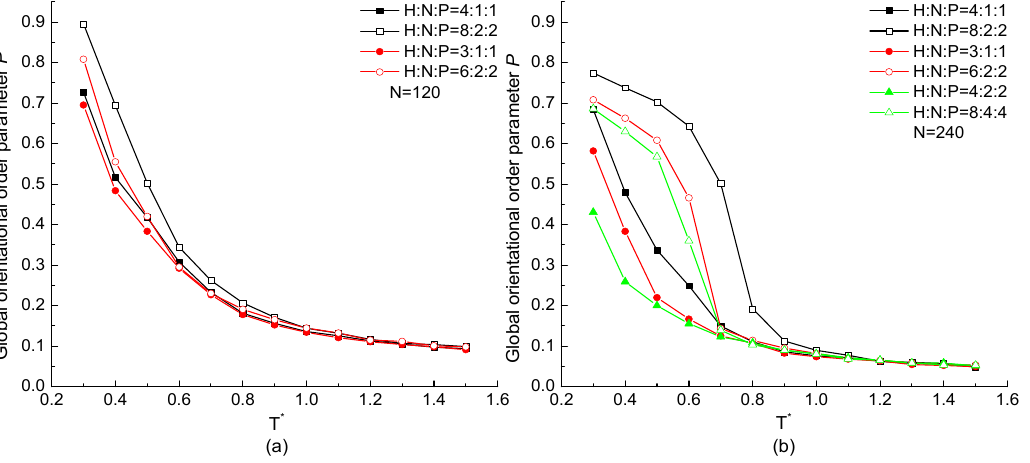
Figure 9. The global orientational order parameter P versus reduced temperature T * of different ratio and serial number of H, N, and P residues with protein chain length ( a ) N = 120, ( b ) N = 240 .